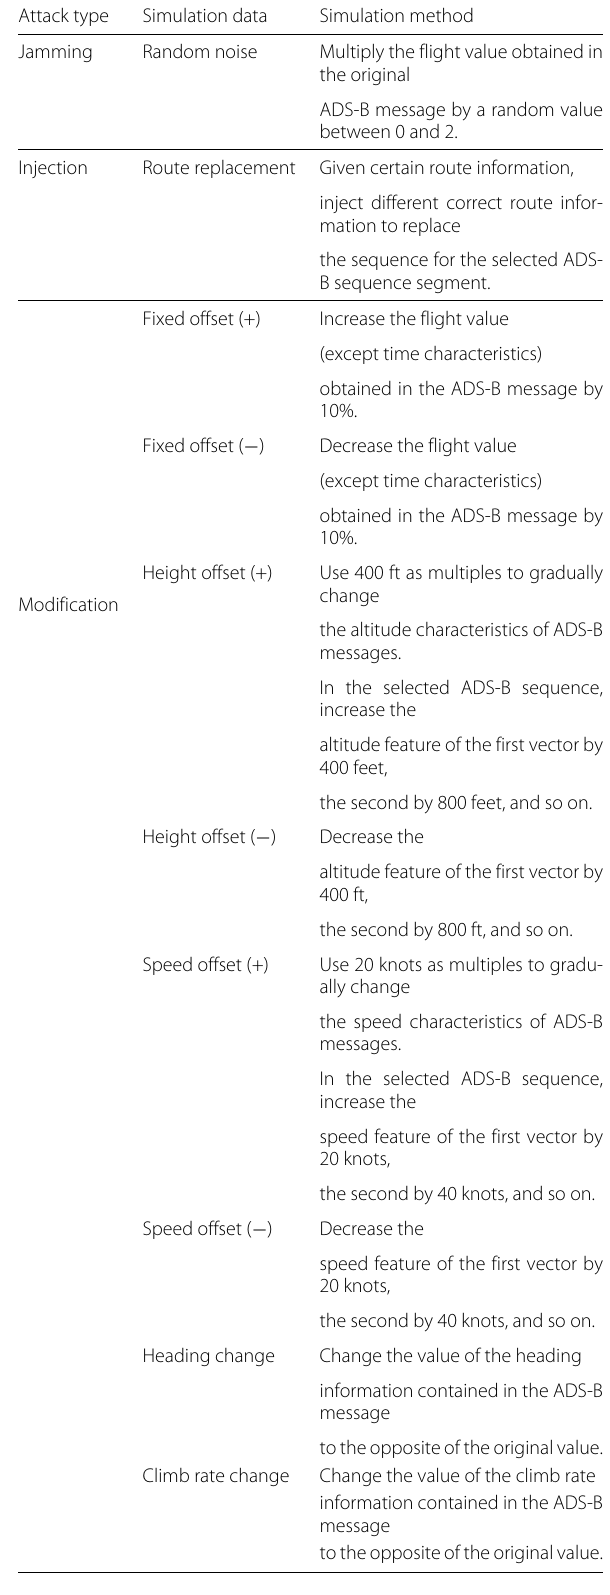
Table 2 ADS-B attack data simulation